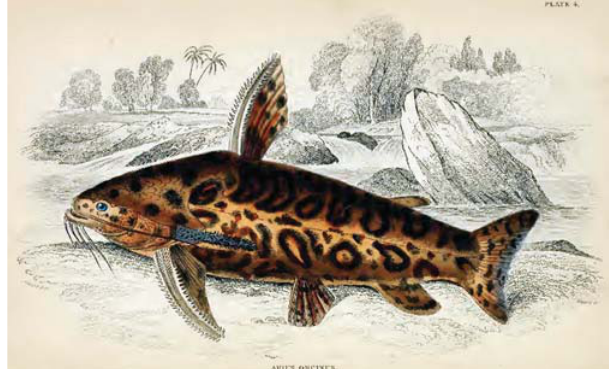
Fig. 1. Schomburgk’s original drawing of Arius oncinus (Schomburgk, 1841: Fig. 4).